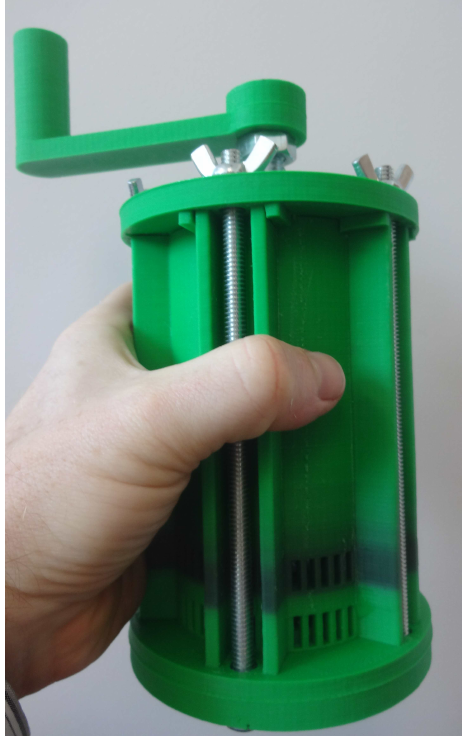
Figure 8. A 3-D printable a cassava press, which uses standard threaded rods and nuts.